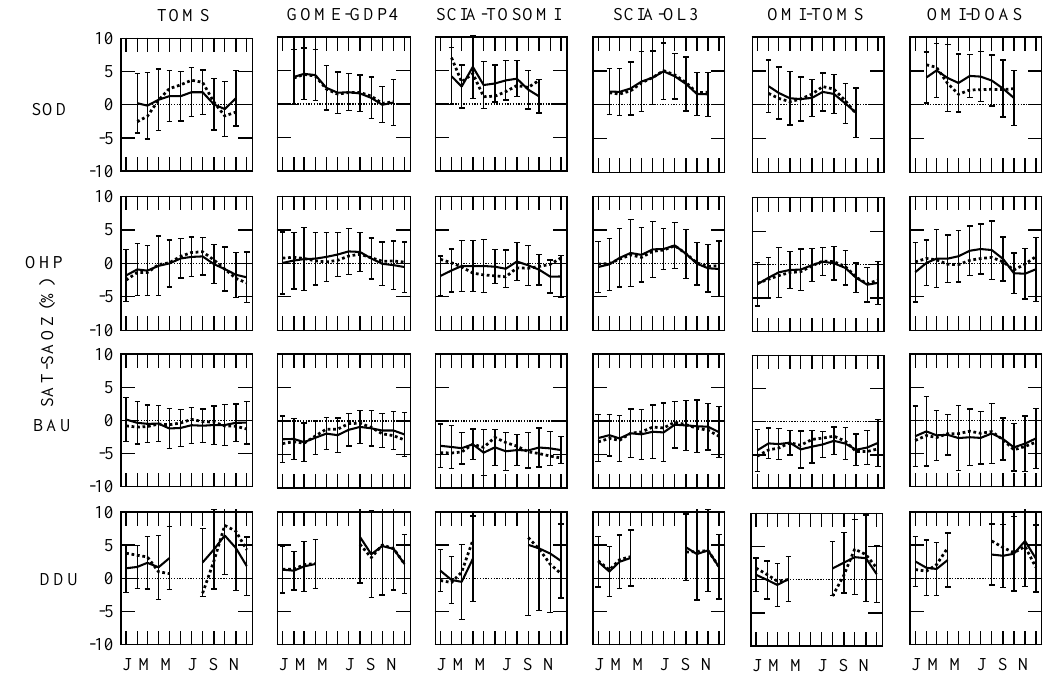
Fig. 13. Seasonal variations before (dotted lines) and after (solid lines) temperature correction. From top to bottom: Sodankyla, OHP, Bauru and Dumont d’Urville. From left to right: TOMS, GOME-GDP4, SCIAMACHY-TOSOMI, SCIAMACHY-OL3, OMI-TOMS, and OMI-DOAS.